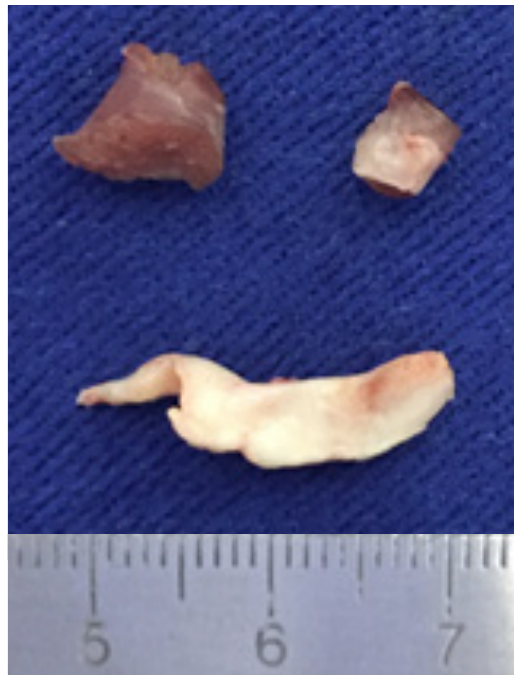
Fig. 2 - Subaortic membrane and papillary